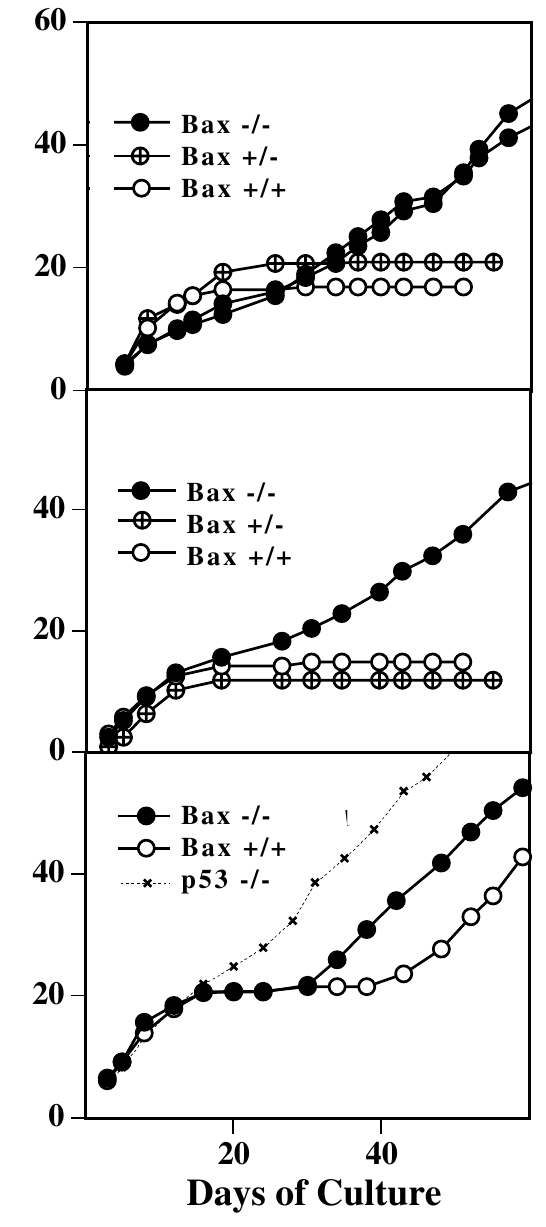
Figure 1 Cells derived from Bax-null muscles immortalized more rapidly than cells from Bax-positive muscles. Primary cultures of Bax (- /-); Bax (+/-); Bax (+/+); and p53 (-/-) myogenic cells were established, serially passaged, and enumerated at each passage as described in Materials and Methods. Results of three independent experiments are shown. As described in the text, myogenic cells from Bax-null muscles (closed circles) immortalized more rapidly and more frequently than myogenic cells from either Bax (+/-) heterozygous muscles (crossed circles) or Bax (+/+) wild-type muscles (open circles). However, myogenic cells from p53 (-/-) muscles (stars with dotted line in Expt. 3) immortalized faster than Bax-null cells without showing the temporary pla- teau in growth rate shown by Bax-null cells. Each symbol denotes a time at which cells were collected and passaged onto new culture dishes as described in Materials and